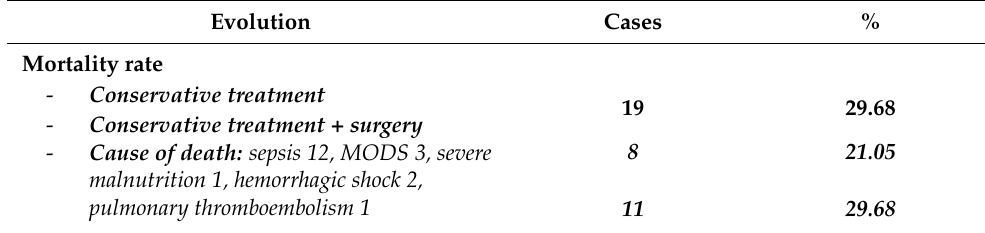
19 29.68 8 21.05 - Cause of death: sepsis 12, MODS 3, severe